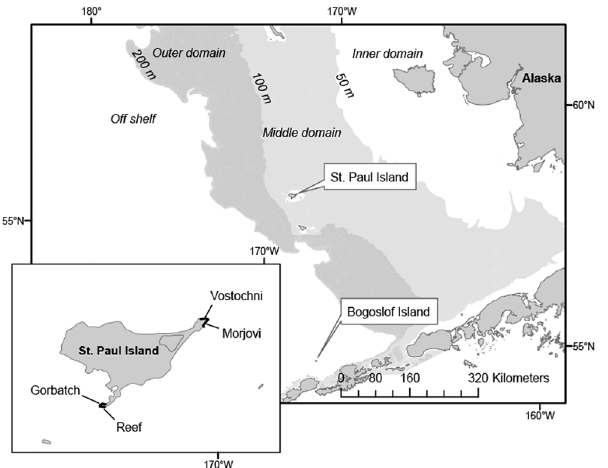
Fig 1. Location of northern fur seal rookeries where blood and scat samples were collected: Reef, Gorbatch, Morjovi and Vostochni rookeries on St. Paul Island and Bogoslof Island. The oceanographic domains in the Bering Sea are